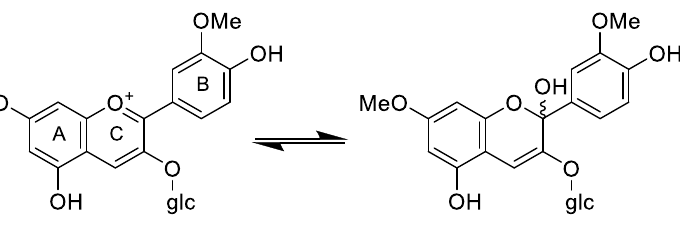
Figure 4. 1 H-NMR spectra of Sphagnorubin C ( 1 , left) and peonidin 3- O -glucoside ( 2 , right) showing selected signals of different equilibrium forms belonging to each of the pigments. The spectra are recorded when 1 and 2 are separately ( a ) dissolved in 5% d -TFA in d -DMSO, ( b ) dissolved in pure d -DMSO, ( c ) after samples b have been equilibrated for 1 h, ( d ) after samples c have been equilibrated for 3–7 days, ( e ) after samples d have been acidified with 5% d -TFA, ( f ) after samples e have been equilibrated for 1 h, ( g ) after samples f have been equilibrated for 5–6 days. The flavylium cation and trans -chalcone forms of 1 are represented by their H6’ and H3 protons, respectively, while both the flavylium cation and the two hemiketal enantiomers of 2 are represented by their anomeric H1’’ protons. The spectra were recorded at 21 °C.